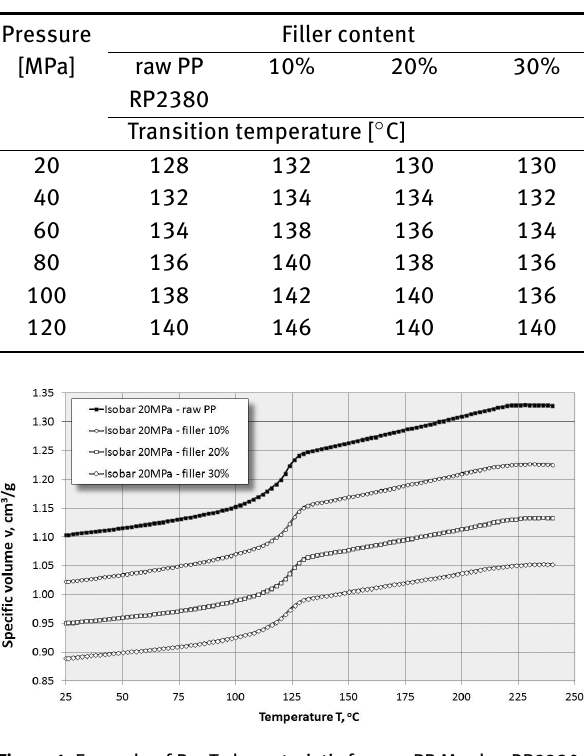
the decrease in the specific volume v ranges from 7.58% to 7.81%, the effect being smaller at lower pressures (from 20MPa to 60MPa), while the highest decrease can be ob- served at the maximum tested pressure, i.e. 120MPa.